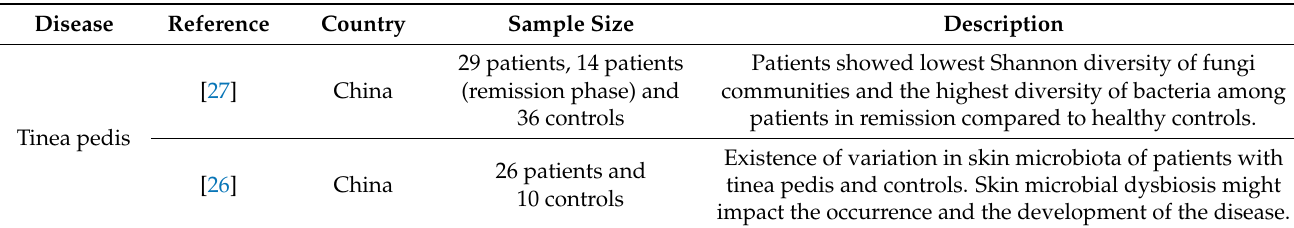
Table 2. Summary of research on tinea pedis and skin